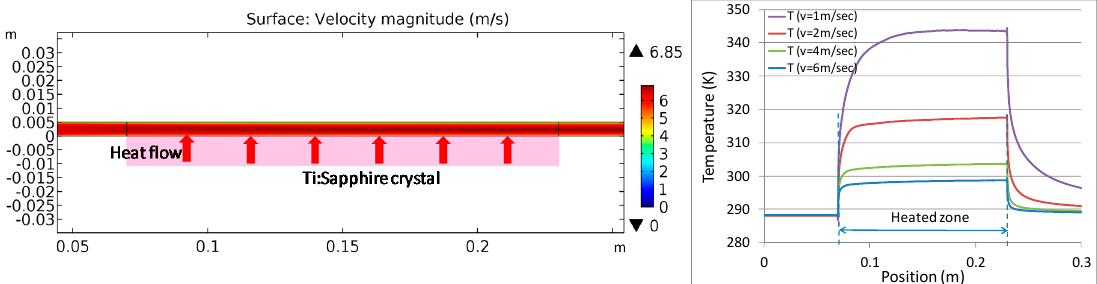
Figure 6. ( Left ) fluid velocity distribution (in m/sec) in the cooling channel in the simulation conditions specified in the text. The position of the Ti:Sapphire crystal is shown for clarity, but it is considered in the thermal simulation only as a thermal boundary condition for the fluid flow (constant surface heat flux). ( Right ) Temperature profile along the Ti:Sapphire crystal surface for different flow speeds, at a heat input of 25 W/cm 2 , with an input temperature of 288.15 K (15 °C).